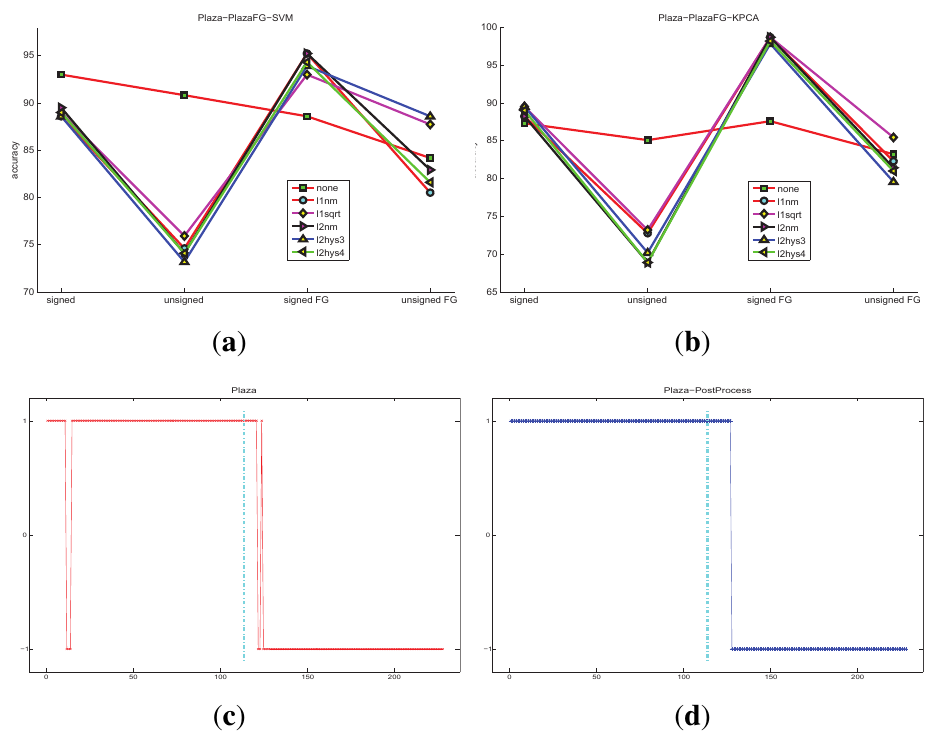
Figure 11. The accuracy of the plaza scene under different classification methods and different features: ( a ) HOFO of the original image and the foreground image; one-class SVM is taken as the classification method, the maximum accuracy is 95 . 2% ; ( b ) HOFO of the original image and the foreground image; KPCA is taken as the classification method, the maximum accuracy is 98 . 7% ; ( c ) original detection results; ( d ) detection results that are post-processed by the state transition restriction strategy; the consecutive frame number threshold is N = 4 . 250 normal frames are used for training; 114 frames are used for normal and abnormal testing,